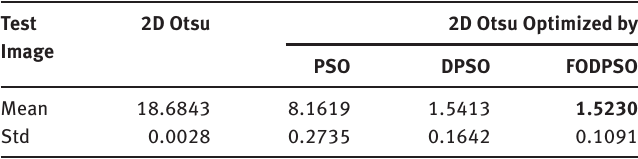
Table 5: Average Computation Time (in Seconds) for Threshold Selection.